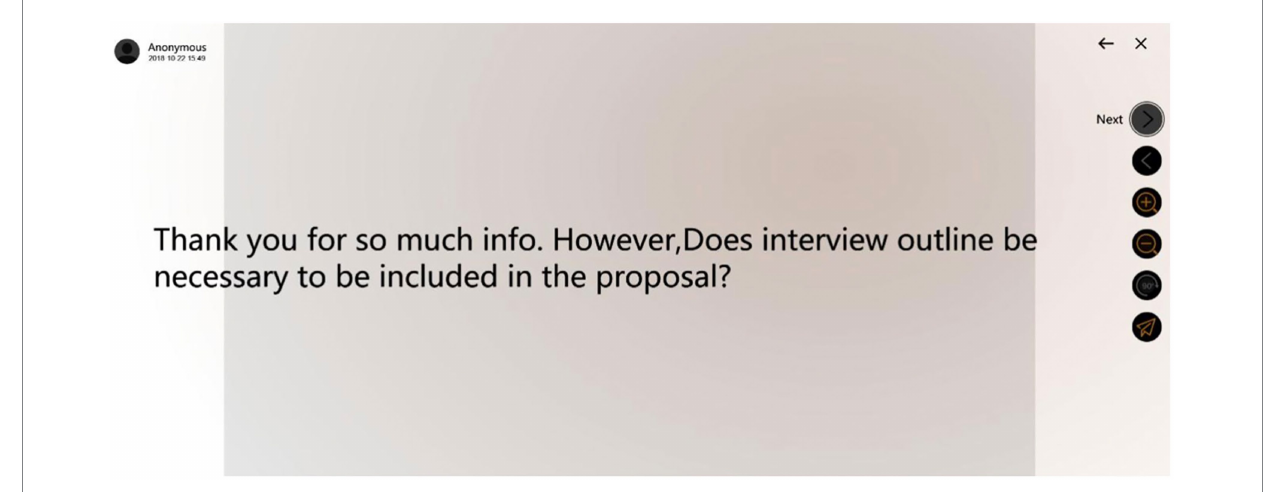
FIGURE 3 Examples of anonymous Rain Classroom